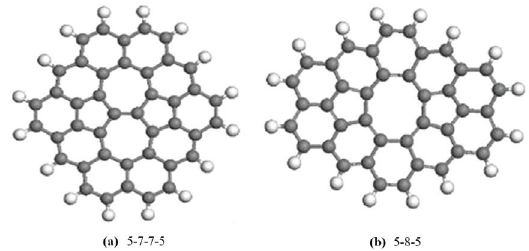
Figure 3. Stone-Wales defect in CNT structure 17